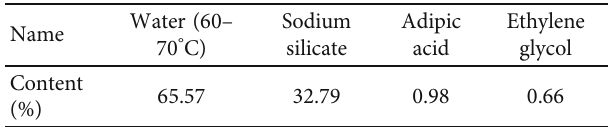
Table 3: Modi fi ed sodium silicate (MS) matching ratio (mass proportion).